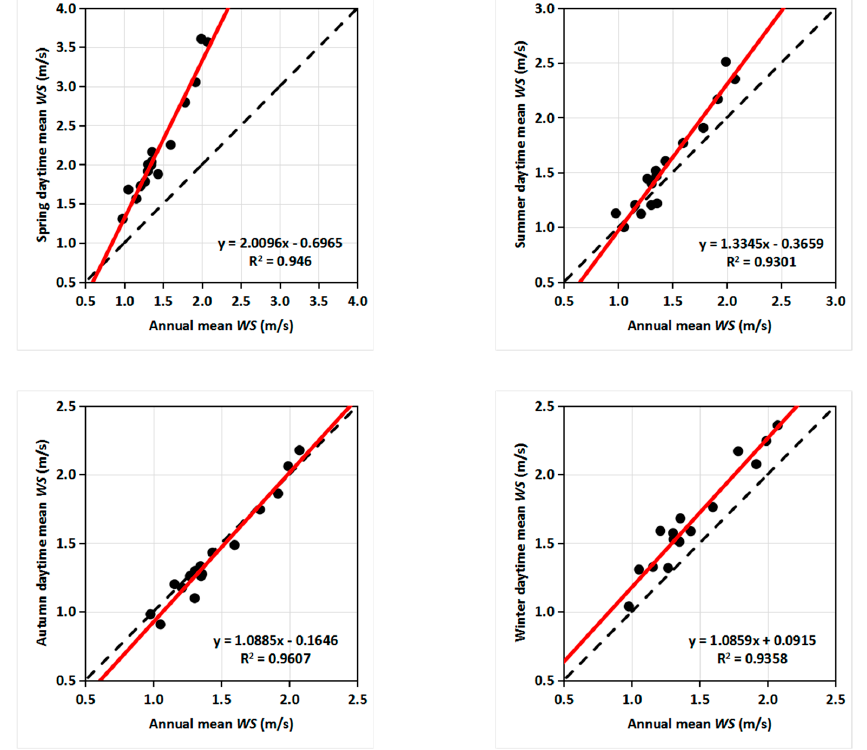
Figure 5. Diurnal mean wind speed at the 16 stations and the local climate zone ventilation performance sequences in four seasons.